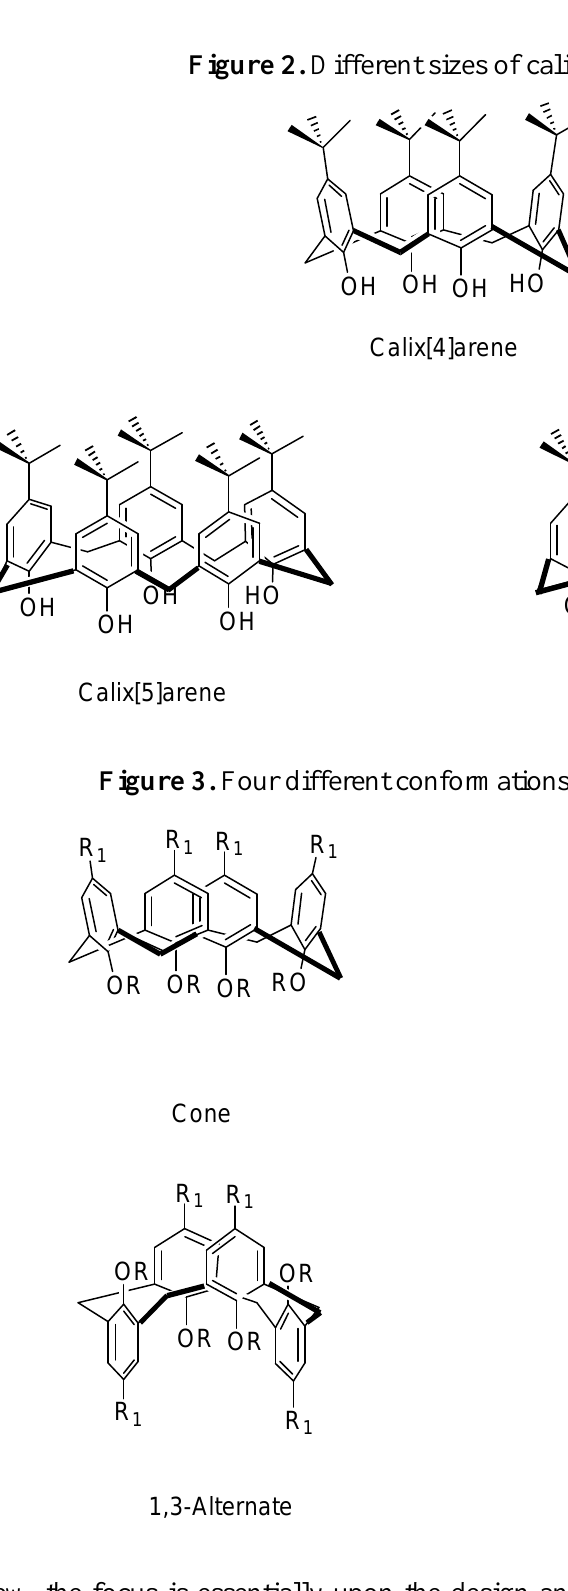
Figure 2. Different sizes of calix[n]arenes